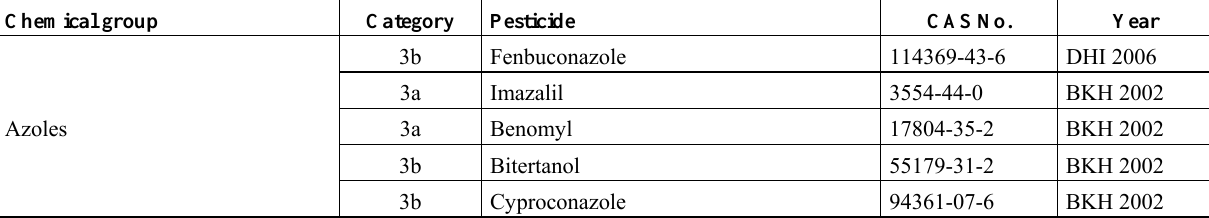
Table 3. Pesticides with insufficient or not known endocrine disrupting effect—Category 3, sub-categories 3a,